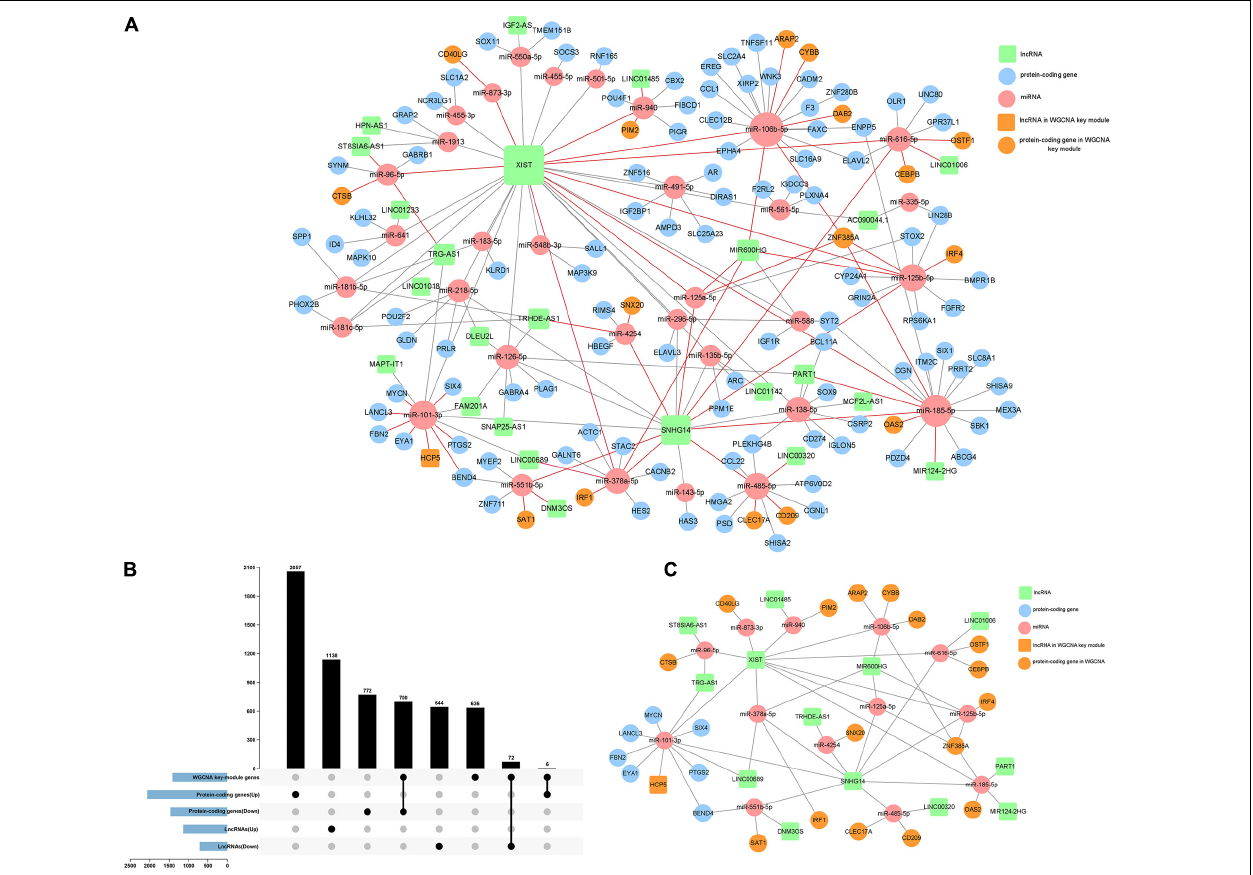
FIGURE 5 | Construction of the immune infiltration-related ceRNA network. (A) A ceRNA network constructed by DEGs between high and low immune score groups (120 mRNA, 25 lncRNAs, and 33 miRNAs). (B) Intersections of DEGs and the key gene cluster (yellow-green module) identified by WGCNA. (C) A highly immune-infiltrating-related ceRNA subnetwork constructed by 23 mRNAs, 14 lncRNAs, and 13